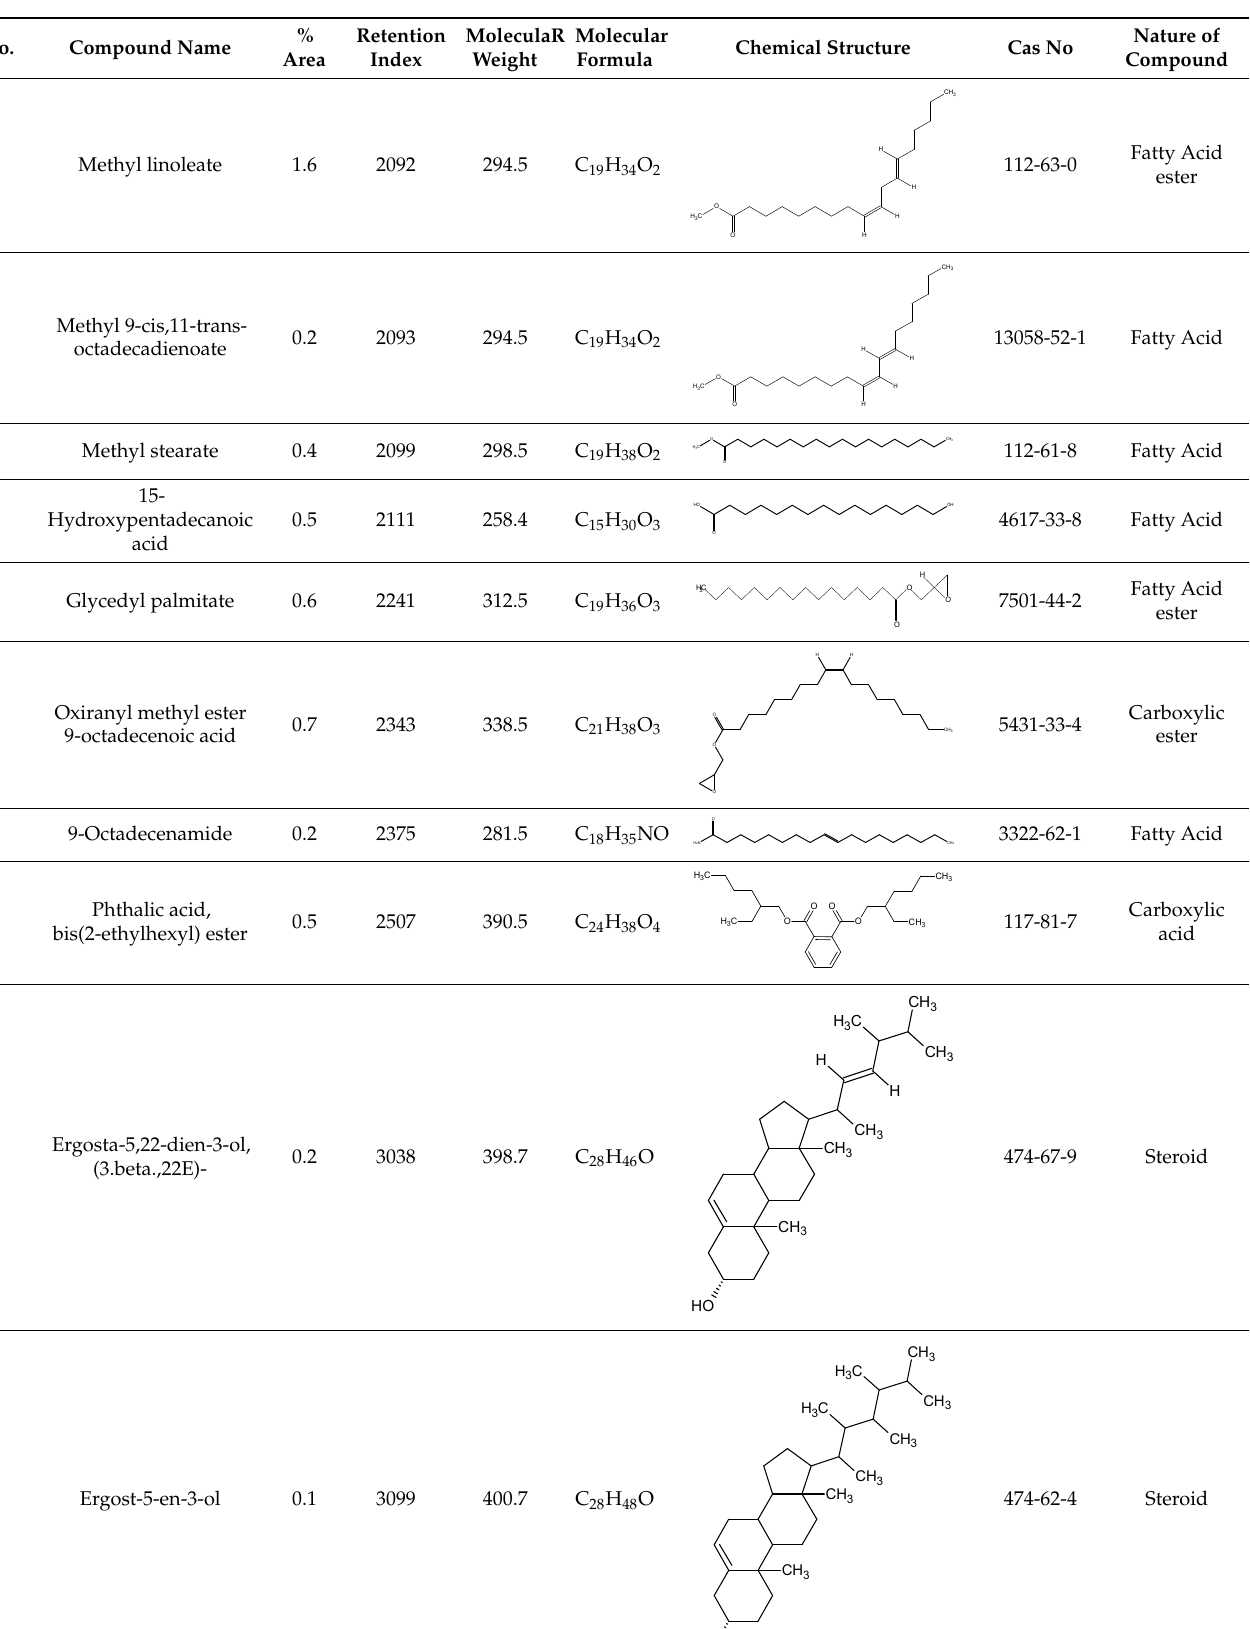
Figure 1. GC–MS chromatogram of methanolic extract of A. nilotica. 3.3. In Vivo Antidiarrheal Effect In comparison to the saline group, both increasing orally delivered dosages of A. nilotica in mice showed significant antidiarrheal effects (Table 2). At the lower tested dose of 200 mg/kg, two out of five mice showed protection, suggesting 40% protection, whereas the higher dose of 400 mg/kg demonstrated 80% protection from diarrhea. In all five cages of mice treated with loperamide (10 mg/kg), no diarrheal spot was observed (100% protection), as detailed in Table 2. Table 2. Antidiarrheal activity of the methanolic extract of A. nilotica on castor oil (10 mL/kg)-induced diarrhea in mice. Treatment (p.o.), Dose